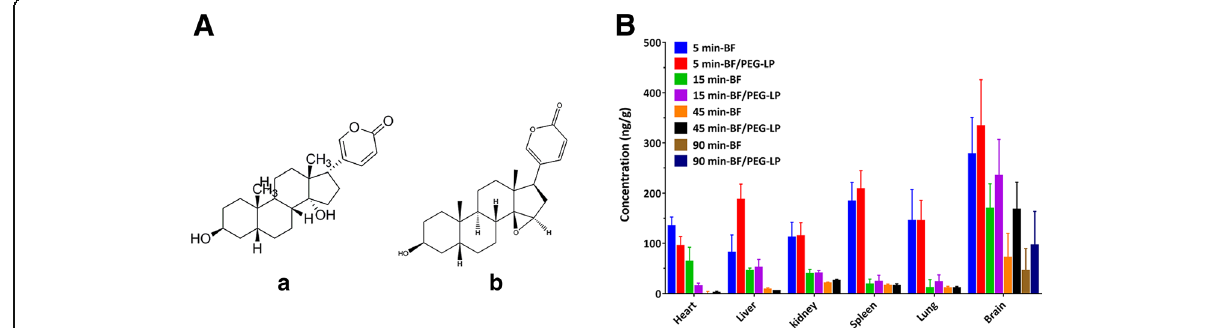
Fig. 6 Tissue distribution of BF in rat organs. A Molecular formulas of bufalin ( a ) and cinobufagin ( b , IS). B Tissue distribution profiles of BF in rats after a single intravenous dose of BF/PEG-LP or BF at 0.5 mg/kg. Data are presented as (cid:2) x ± s ( n = 6). Abbreviations: BF, bufalin; BF/PEG-LP, bufalin- loaded PEGylated liposomes; IS, internal